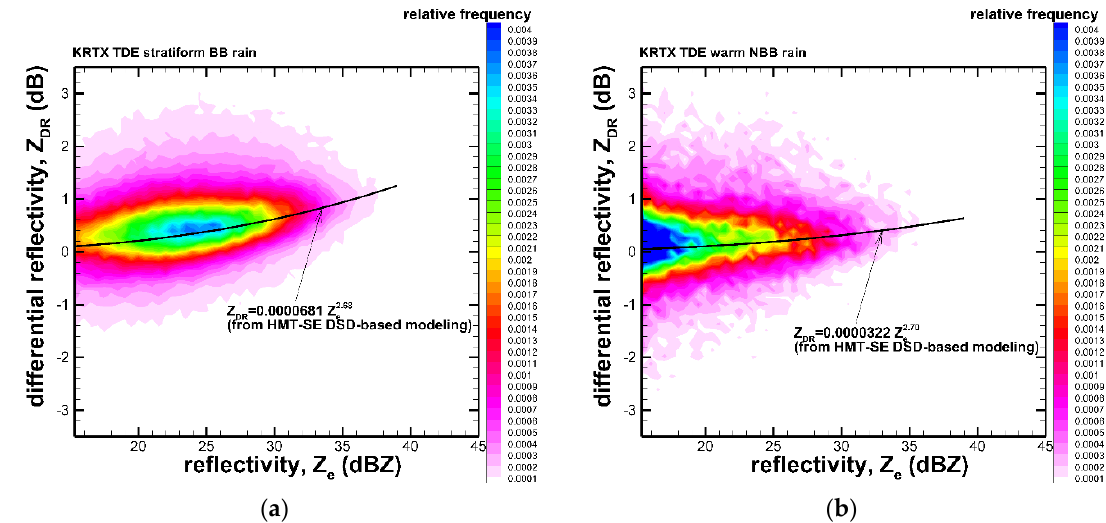
Figure 3. Observed differential reflectivity-reflectivity frequency scatter plots for ( a ) stratiform bright-band (BB) rain and ( b ) warm non-bright band (NBB) rain. Lines and equations show the mean theoretical Z DR -Z e Equations (1) and (2) found through modeling in [6].